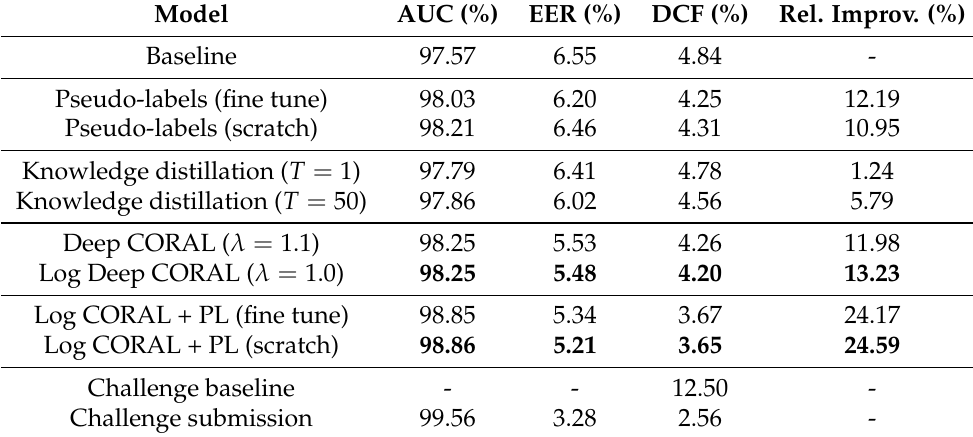
Table 9. AUC (%), EER (%), DCF (%) and DCF relative improvement (%) over the unadapted baseline model on the FS02 development partition using the three evaluated domain adaptation methods, and the cascaded application of two of them with the best performing hyperparameter configuration in terms of DCF metric compared to the original challenge baseline and our submission to the challenge trained using in domain